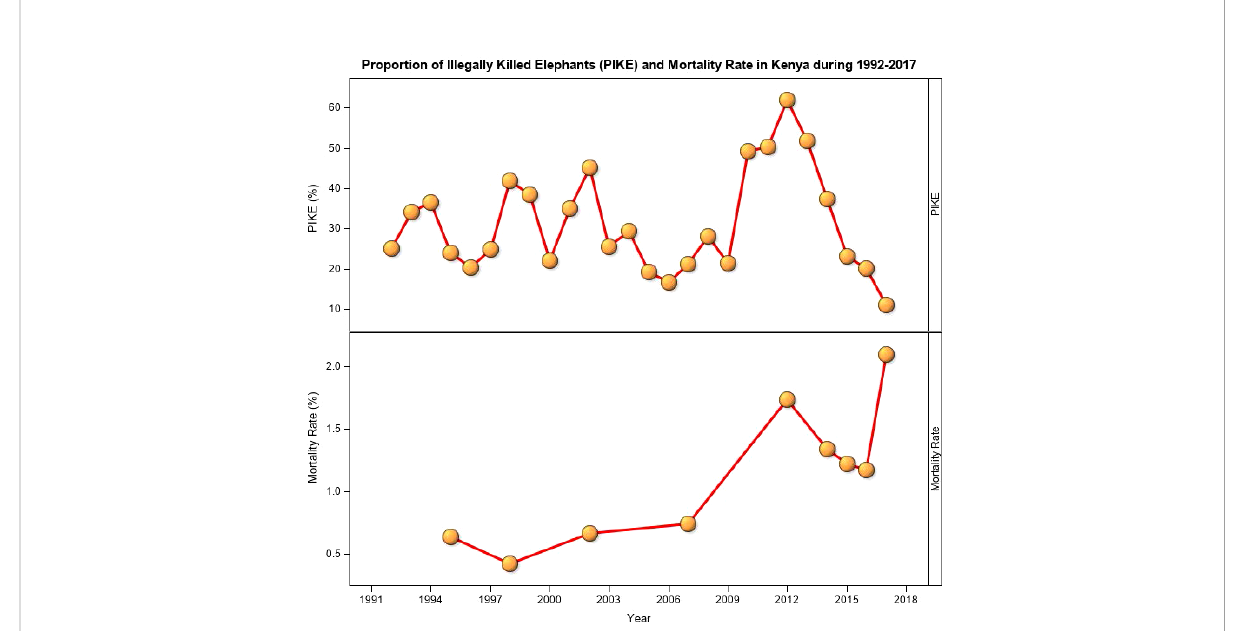
FIGURE 7 The proportion of illegally killed elephants (PIKE) and elephant mortality rate in Kenya during 1992